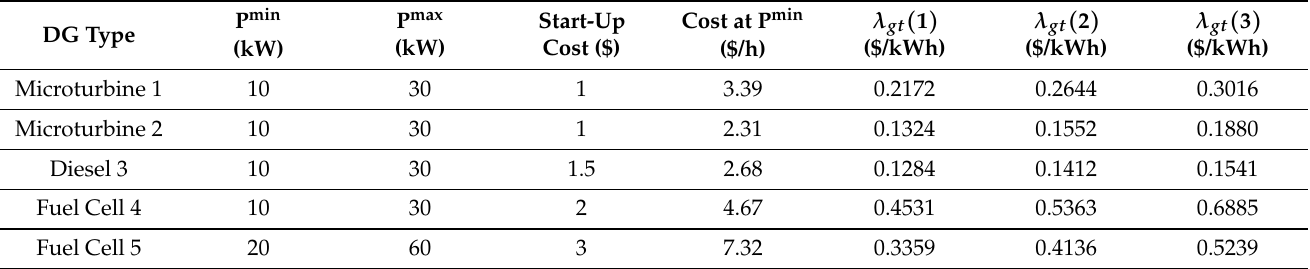
Table 2. Dispatchable DGs